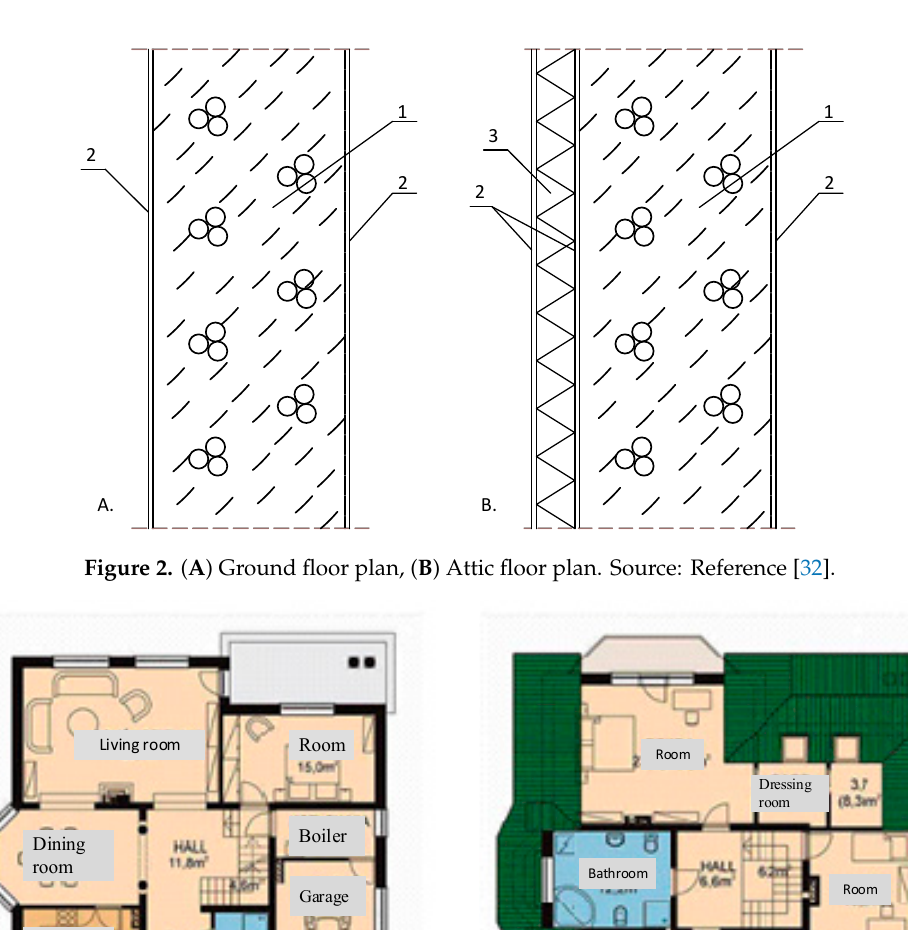
Figure 1. (A ) Ground floor plan, ( B ) Attic floor plan. Source: Reference [32].